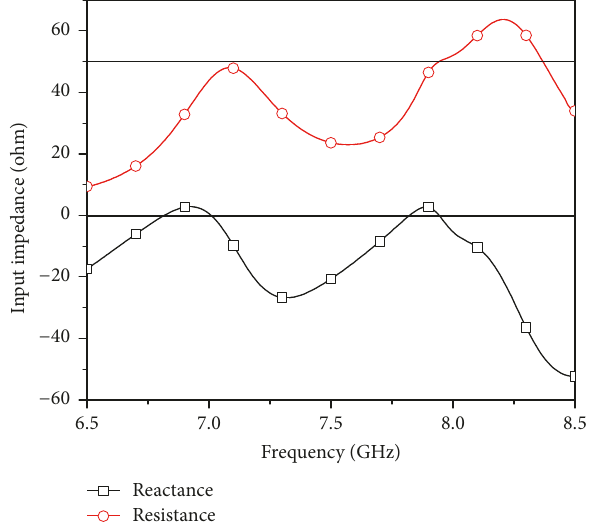
Figure 3: It illustrates the input impedance of the DR-antenna.